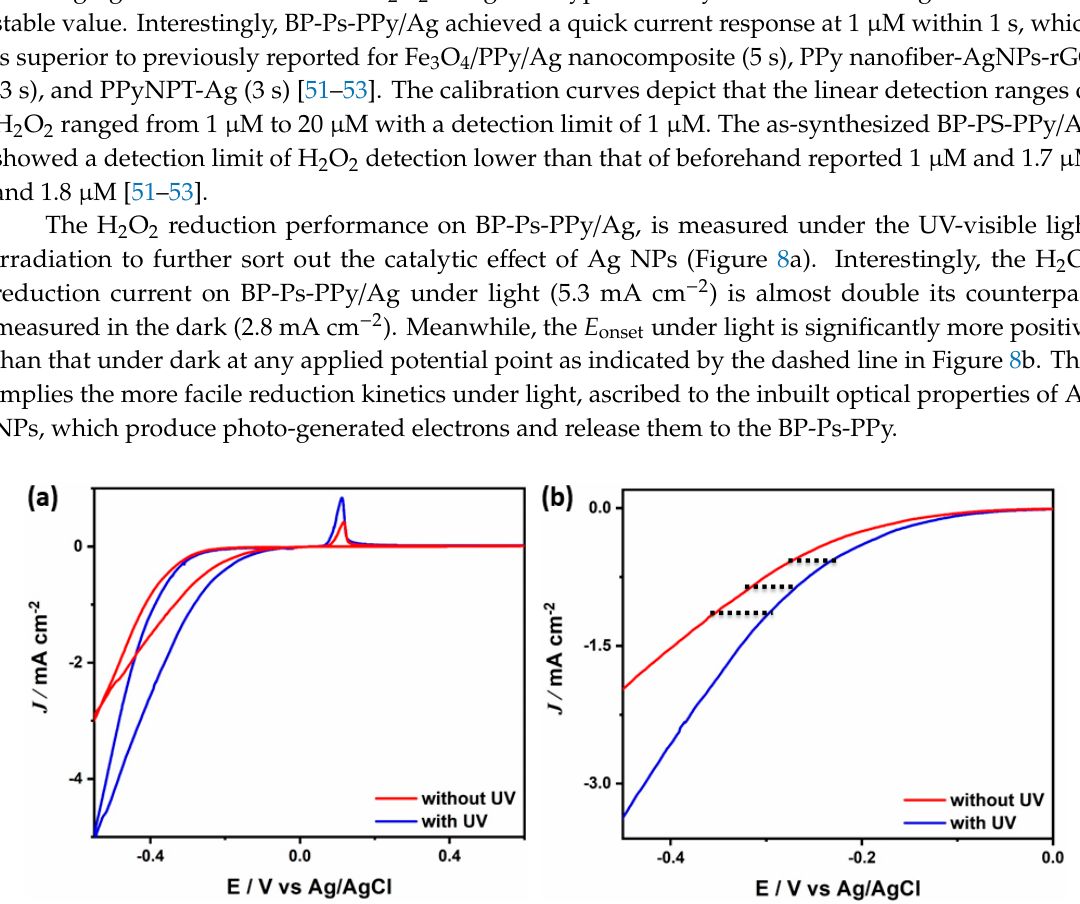
Table 2. Summary of the polypyrrole-based composites on various kinds of supports for H 2 O 2 detection. Support/Substrate Material Experimental Details